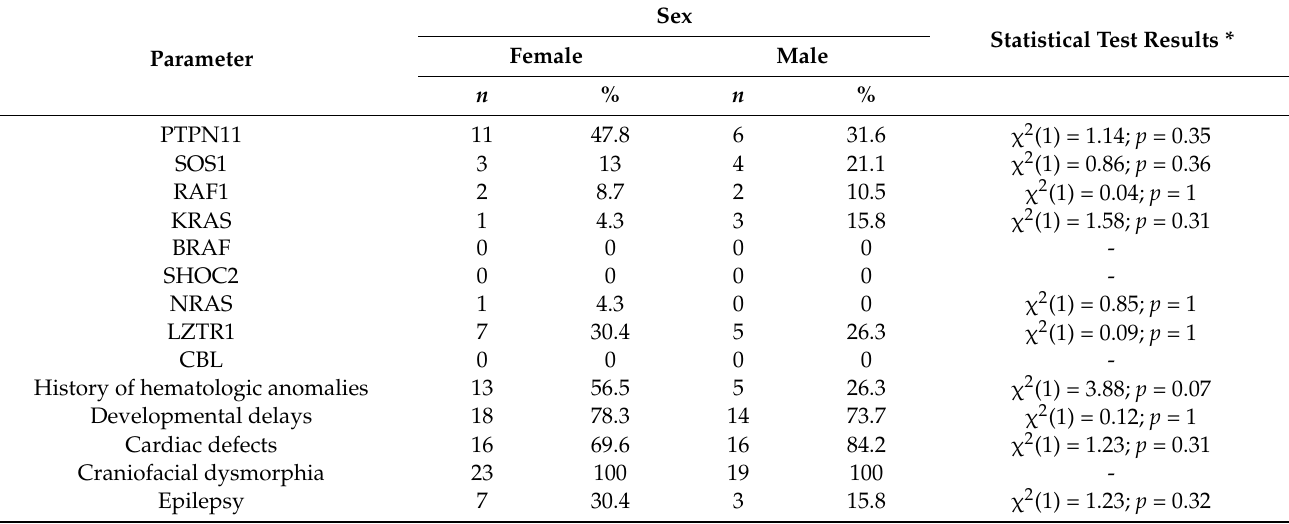
Table 7. Dependency of the sex of the studied group on the analyzed variables.